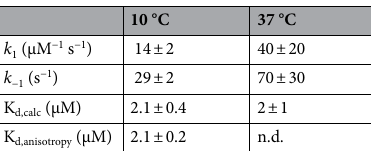
Table 2. Kinetic parameters of PDF binding to 70S ribosomes. Rates measured at 10 °C were extrapolated to 37 °C and K d,calc values were calculated from rate constants (“Materials and methods”). K d,anisotropy was measured by 70S ribosomes titration at 10 °C (Fig. 3d). n.d., not determined.